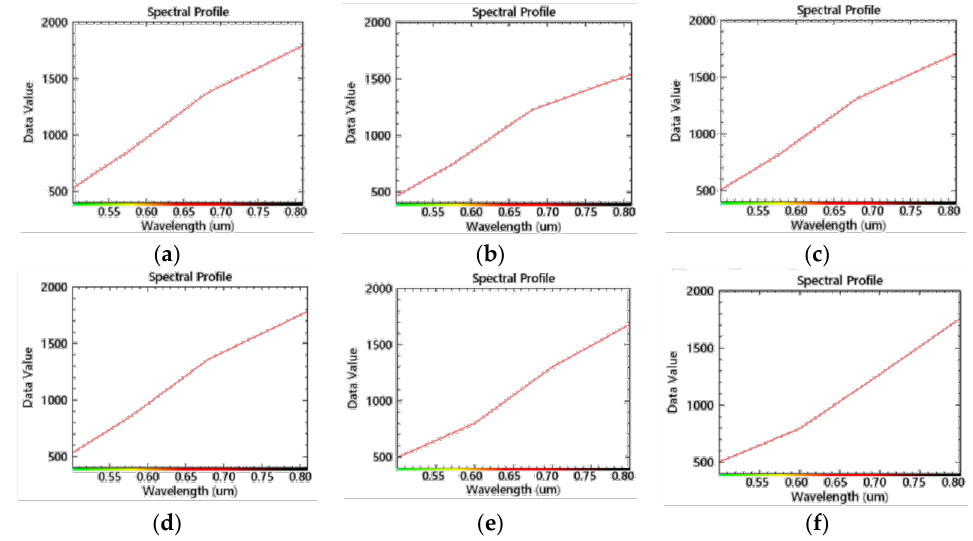
Figure 4. The bare ground spectrum curves of different fusion images. ( a ) MS image; ( b ) GS fusion image; ( c ) PCA fusion image; ( d ) NND fusion image; ( e ) Pansharpening fusion image; ( f ) HPF fusion